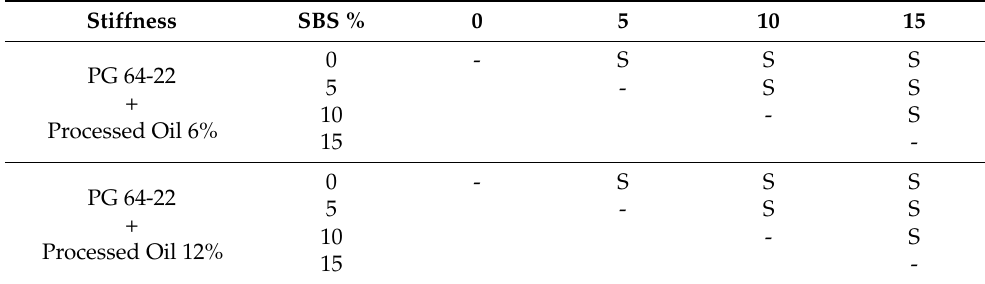
Table 12. Statistical analysis results of stiffness for RTFO + PAV aged PG 64-22 with processed oil as a function of SBS content at − 24 ◦ C ( α =